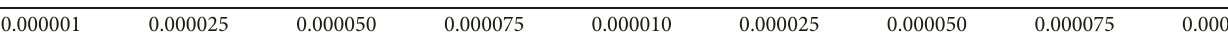
Figure 8: The distribution of Seq3. Table 6: Threshold sequence.